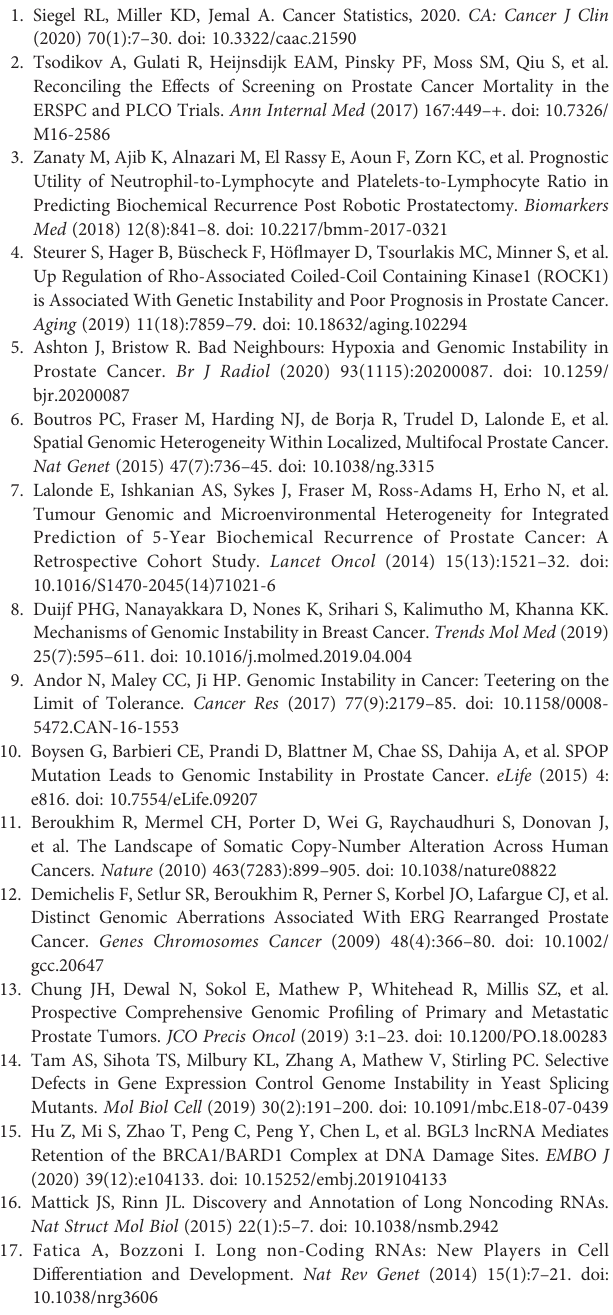
Blue nodes represent transcription factors, purple nodes represent high-risk lncRNAs, pink nodes represent low-risk lncRNAs. Positive regulations between TFs and lncRNAs are displayed as red lines. Negative regulations are displayed as green lines. Supplementary Data Sheet 2 | LncRNAs-mRNAs network. Supplementary Data Sheet 3 | TFs-lncRNAs